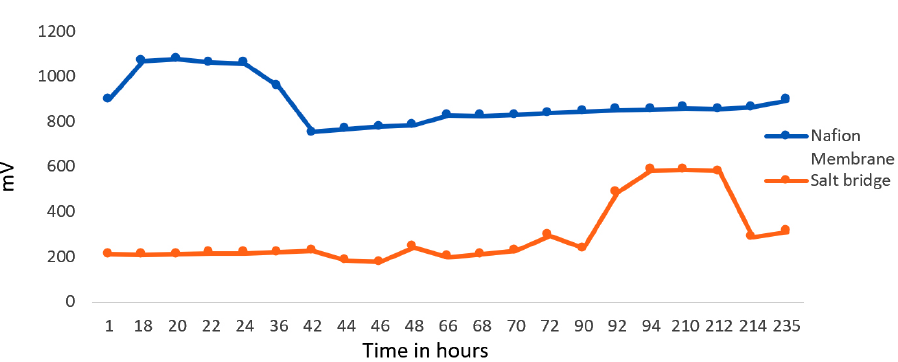
Fig. 3. Electricity generation by Exiguobacterium sp SU-5 in 0.5% carboxy methyl cellulose containing medium.